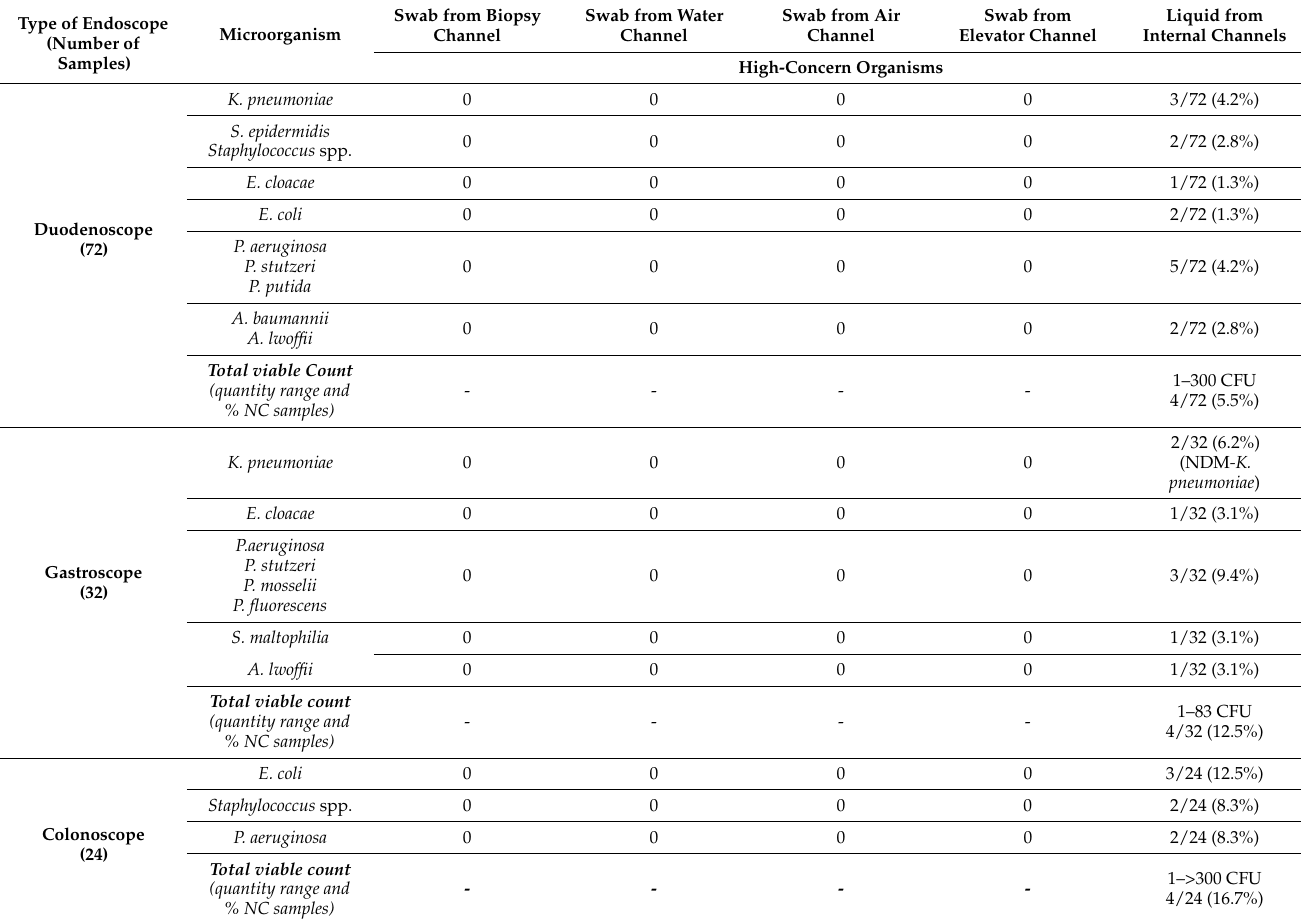
Table 3. High-concern organisms isolated during the third phase of microbiological surveillance. Swab from Biopsy Type of Endoscope Microorganism (Number of Samples)